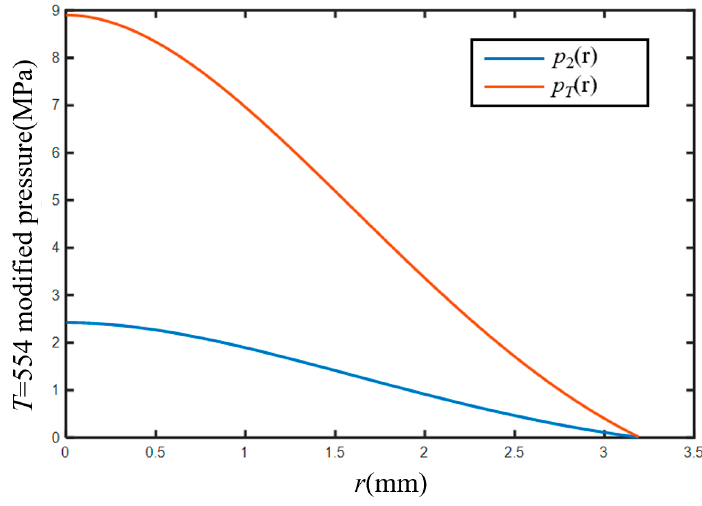
Figure 8. Pressure distribution curves ( T = 554 N, n = 3). The influence of discrete order on pressure correction was calculated in two cases of T = 0 N and T = 554 N. The contact pressure curves of higher discrete orders such as 5th, 8th and 100th were calculated, respectively, as shown in Figure 9. It can be seen that for different tangential loads, the higher the discrete order, the smaller the correction amplitude. The pressure curves of the 100th discrete and 1000th discrete were basically the same. That is, the pressure correction curve p T ( r ) is stable when the discrete order is high.